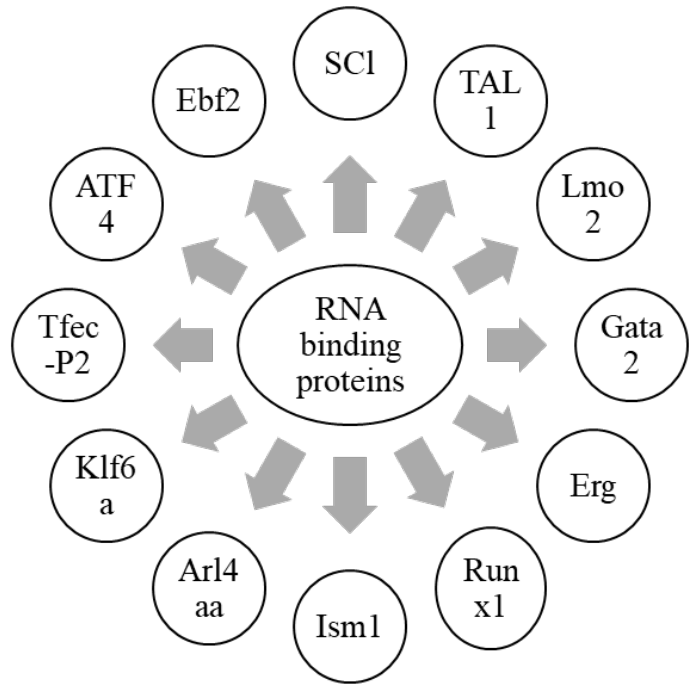
Figure 2. Graphical representation of RNA-binding proteins in hematopoietic niche. Different RNA-binding proteins which are involved in the formation of HSCs, along with the maintenance of hematopoiesis, are summarized in this figure. Together with a wide array of HSC niche factors, RNA-binding proteins are an essential component in the formation of HSCs, as well as the maintenance of